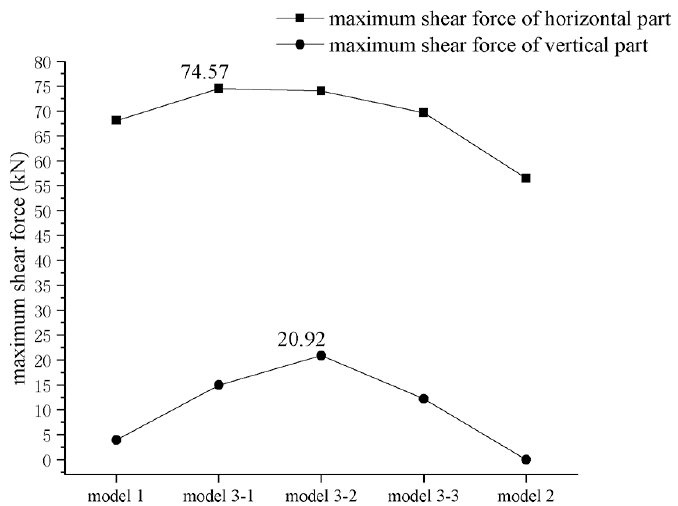
Figure 19. Maximum shear forces of the horizontal part and vertical part for the bH-shaped compo- nents in each model.